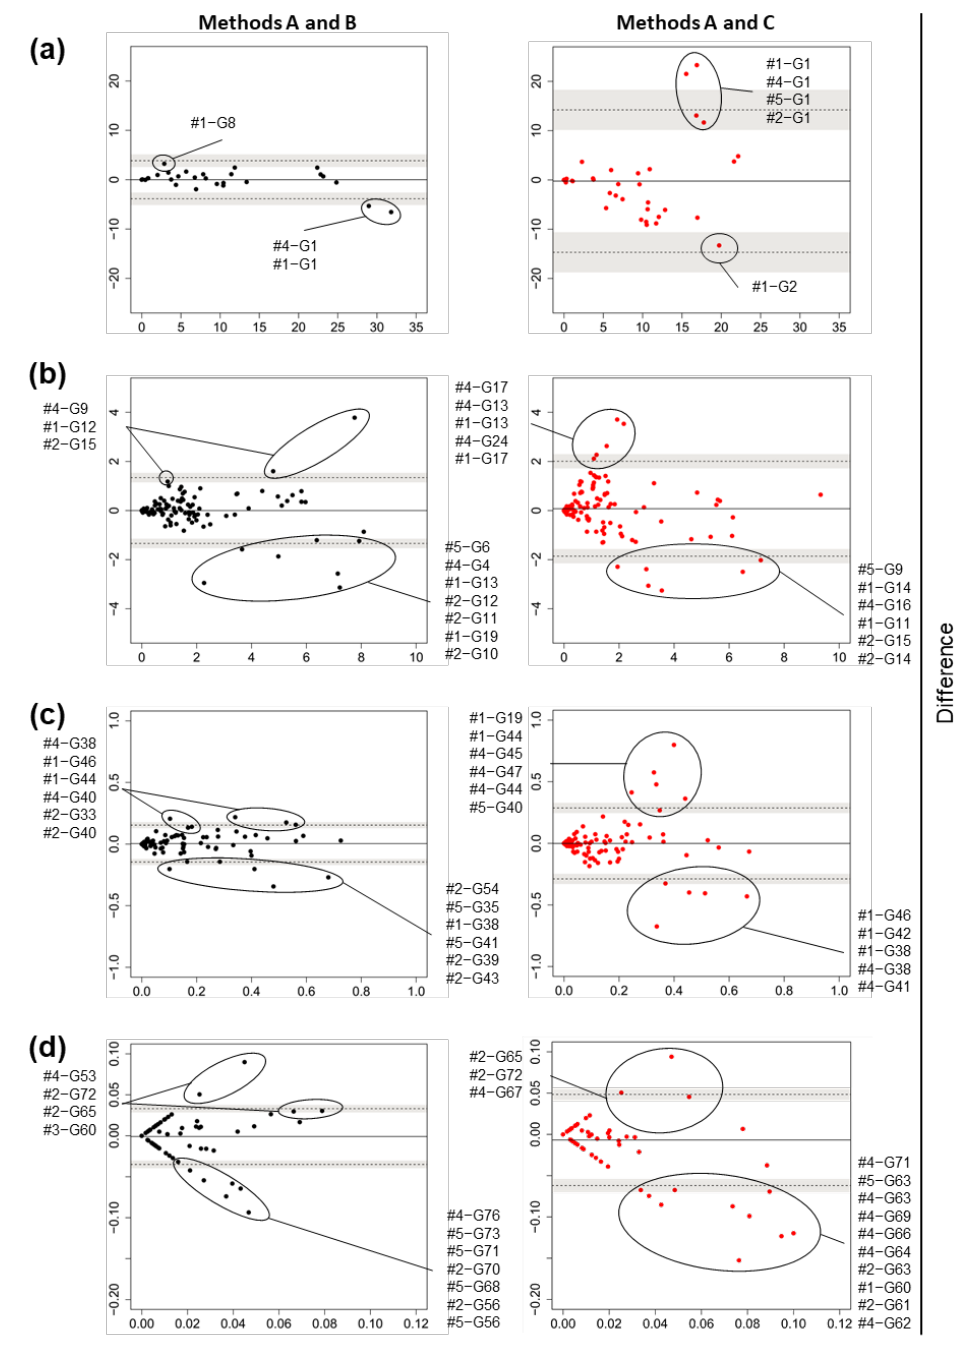
Figure 5. Research I: Bland–Altman plots of the relative abundance of fecal bacteria at the genus level obtained by each method from five adult volunteers. Comparisons between Methods A – B (left) and Methods A – C (right). The relative abundance of bacteria in each specimen was plotted. ( a ) Their maximum abundance in any of the specimens was ≥10%; ( b ) ≥1% and <10%; ( c ) ≥0.1% and <1%; ( d ) <0.1%. Solid lines indicate the means of the differences between the two test values, dotted lines indicate the limits of agreement (the mean of the difference ± 1.96 × standard deviation), and the gray shaded area indicates the 95% confidence interval of the limits of agreement. For Methods A and B, stool samples were collected using commercial collection tubes. For Method C, urine and stool samples were applied to disposable diapers. For Methods B and C, the samples were stored at − 80 °C for 2 months.